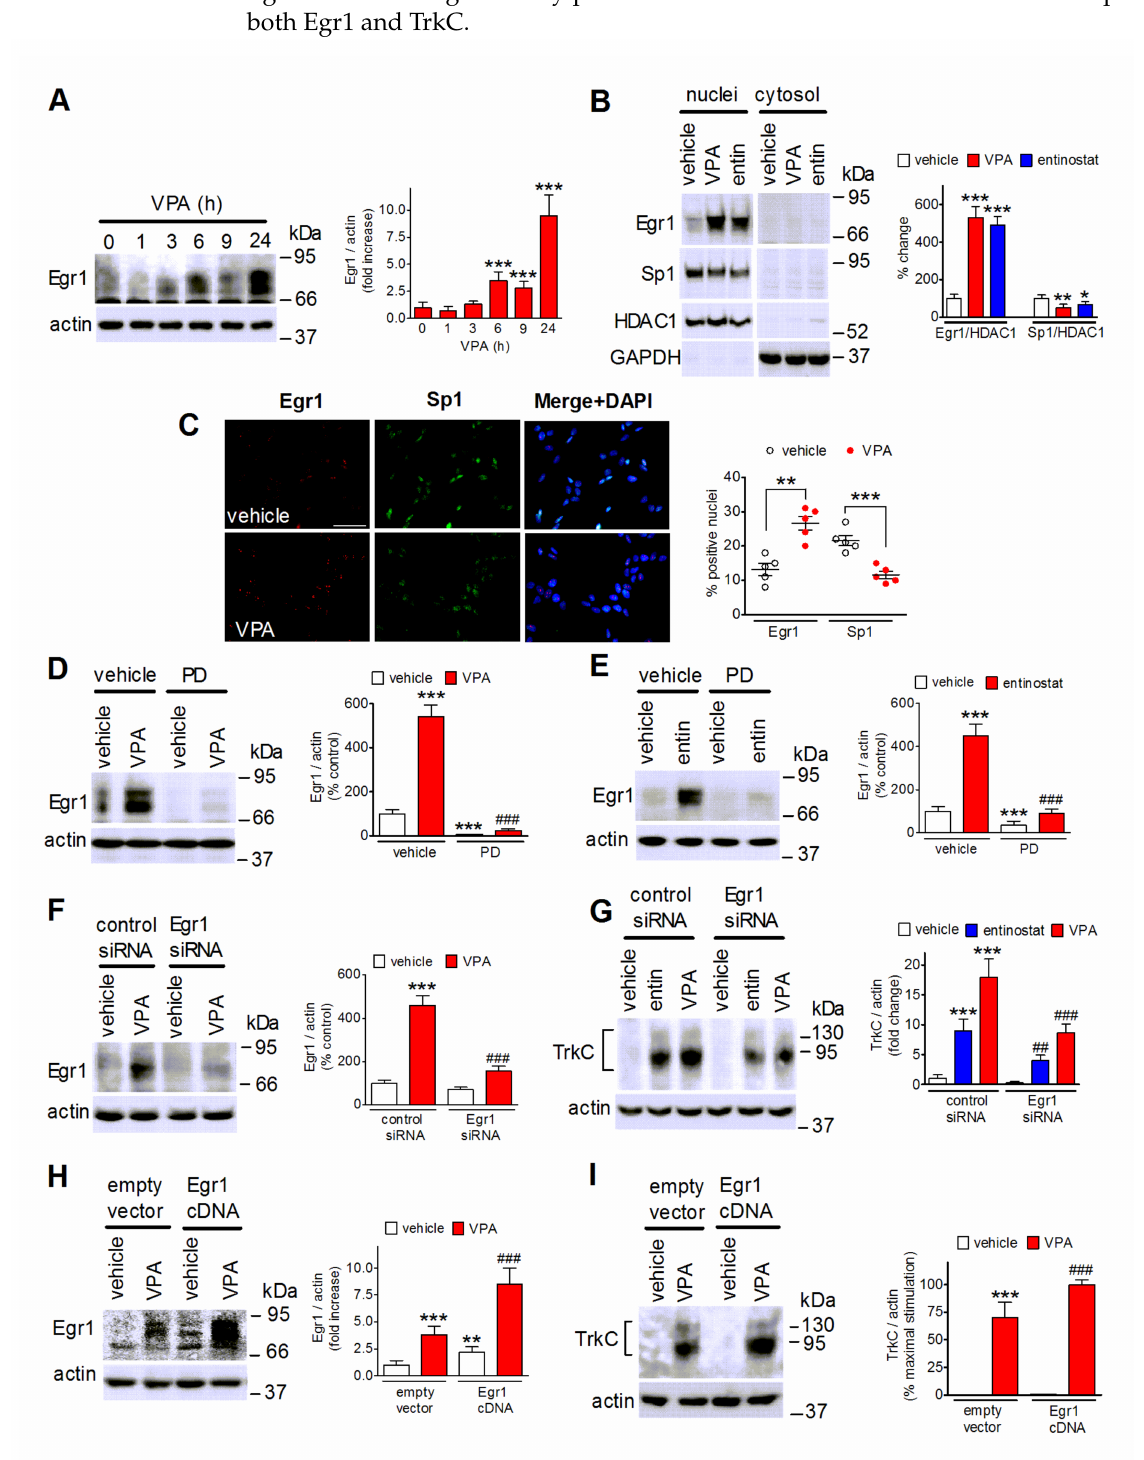
Figure 6. Induction of Egr1 mediates TrkC upregulation by VPA. ( A ) SH-SY5Y cells were incubated in the presence of 1 mM VPA for the indicated periods of time. Zero time samples (control) were treated with vehicle. Cell lysates were analyzed for Egr1 and actin. Values are the mean ± SD of four experiments. *** p < 0.001 vs. control. ( B ) SH-SY5Y cells were treated for 24 h with either vehicle, 1 mM VPA, or 1 µ M entinostat (entin). Nuclear extracts and cytosolic fractions were analyzed for Egr1, Sp1, HDAC1 and GAPDH levels. Densitometric ratios of Egr1/HDAC1 and Sp1/HDAC1 in nuclear extracts are reported as